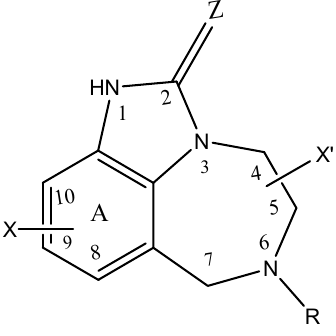
Figure 1. General structure of TIBO derivatives studied.